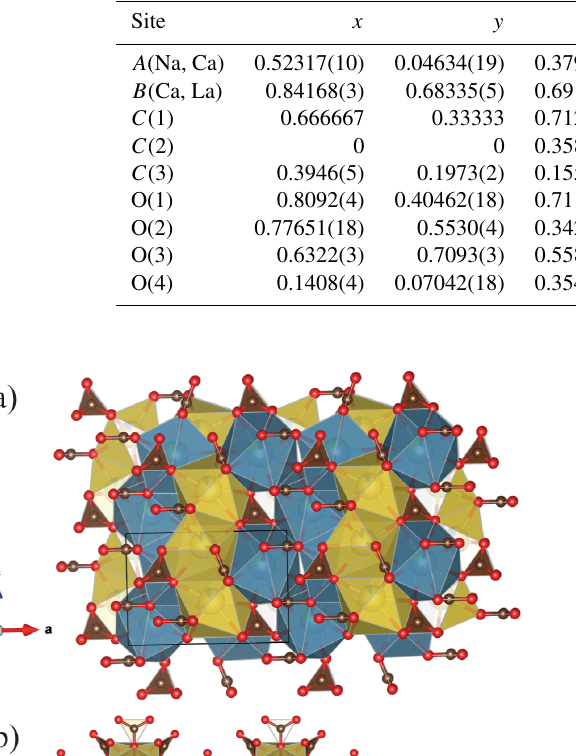
Table 3. Atomic coordinates, site occupancies and equivalent displacement parameters (Å 2 ) in ambient conditions of the burbankite studied in this work.